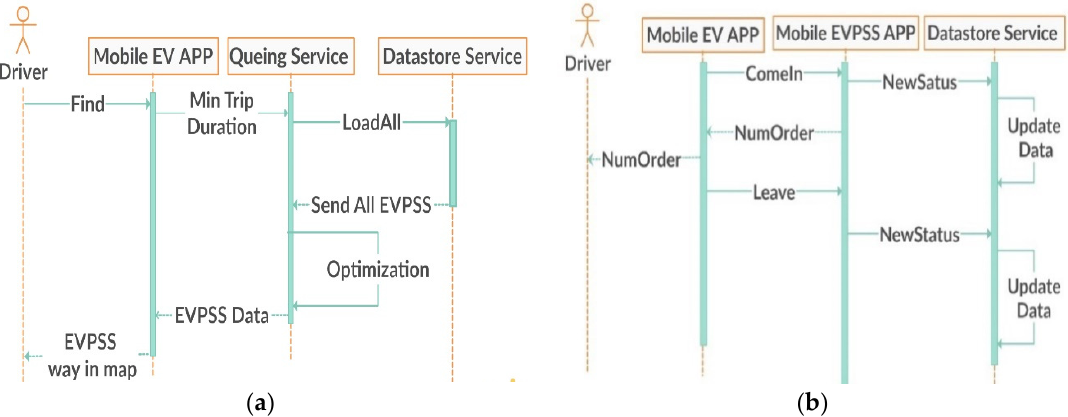
Figure 3. Communication scenario: ( a ) between electric vehicles (EV) and Server; ( b ) between electric vehicle public supply station (EVPSS) and Server. Reproduced with permission from [12].